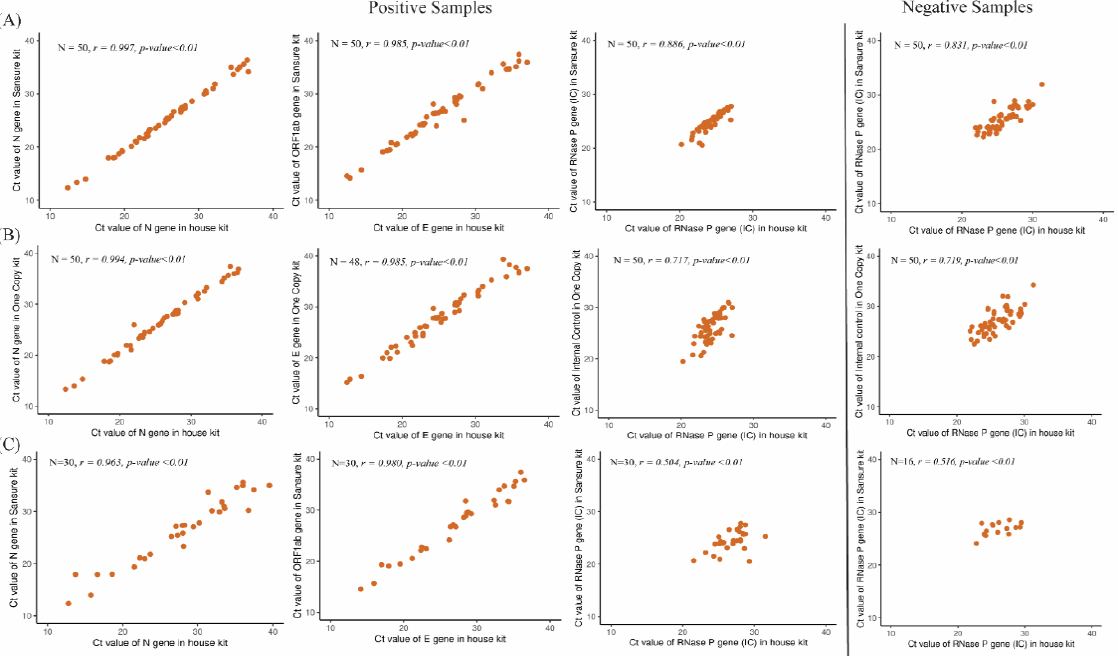
Figure 4. Pearson correlation analysis of Ct values of E , N , RNase P between in house kit and reference kits. ( A ) Pearson correlation between N , RNase P , E gene between In house and Sansure kit at site 1 (Sansure has ORF1ab gene instead of E gene), ( B ) Pearson correlation between N , RNase P , E gene between In house and One copy kit at site 1, ( C ) Pearson correlation between N , RNase P , E gene between In house and Sansure kit at site 1 (Sansure has ORF1ab gene instead of E gene).